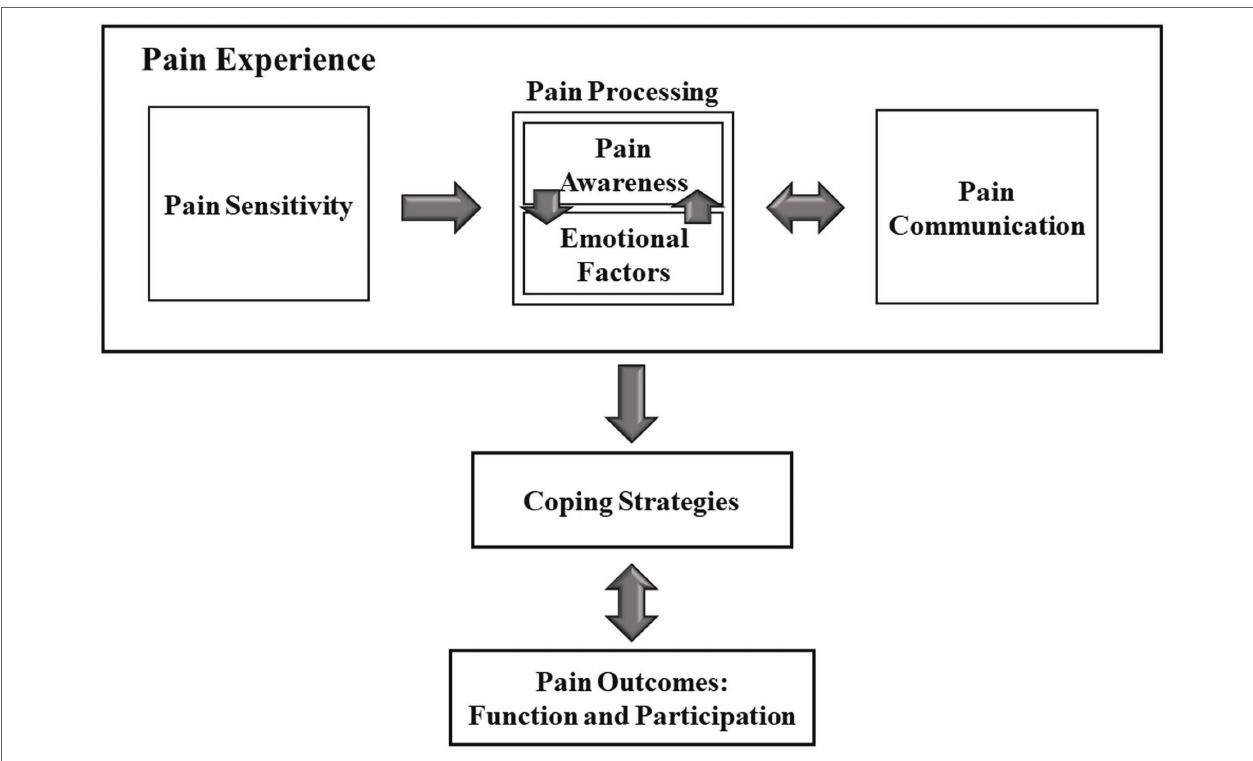
FIGURE 1 | Pain–participation